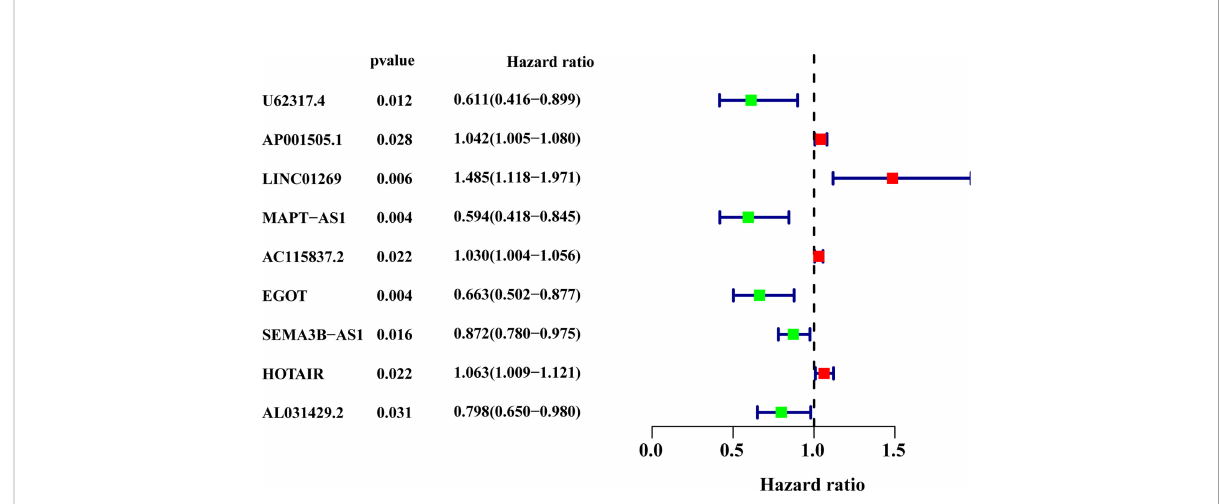
FIGURE 4 The forest plot of the nine lncRNAs generated from the univariate Cox regression analysis (criteria: p -value < 0.05). HR, hazard ratio; CI, con fi dence interval.